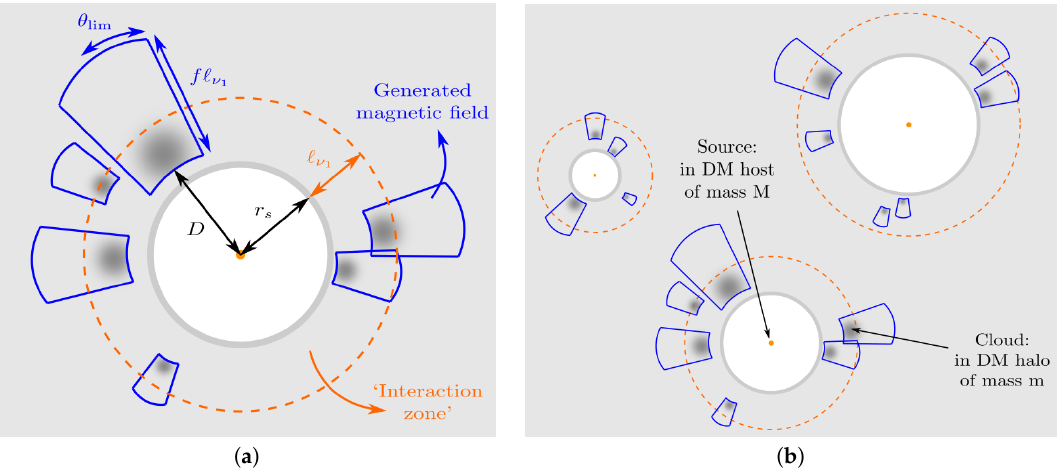
Figure 3. Illustration of the approach we followed for estimating the global magnetization level of the IGM. We first ( a ) evaluated the magnetic field generated around one source, surrounded by a distribution of clouds, and then ( b ) considered a distribution of sources. The orange dot represents an ionizing source. Gray spots represent small baryonic inhomogeneities in the IGM. Blue frames delineate the characteristic regions that are magnetized around such gas